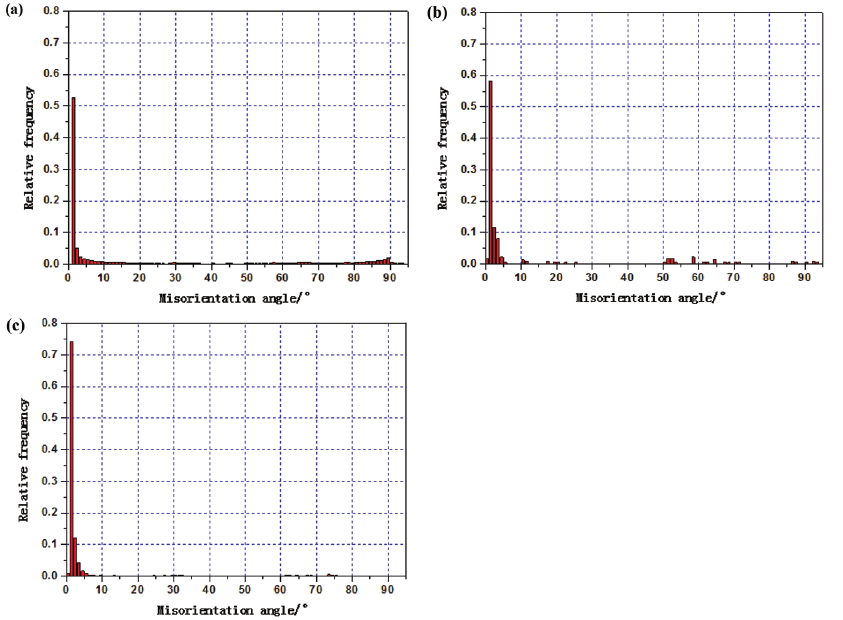
Figure 17: Distribution of grain boundary misorientation angles ( α phase): (a) 750°C, 0.001 s − 1 ; (b) 800°C, 0.001 s − 1 ; (c) 800°C, 1 s − 1